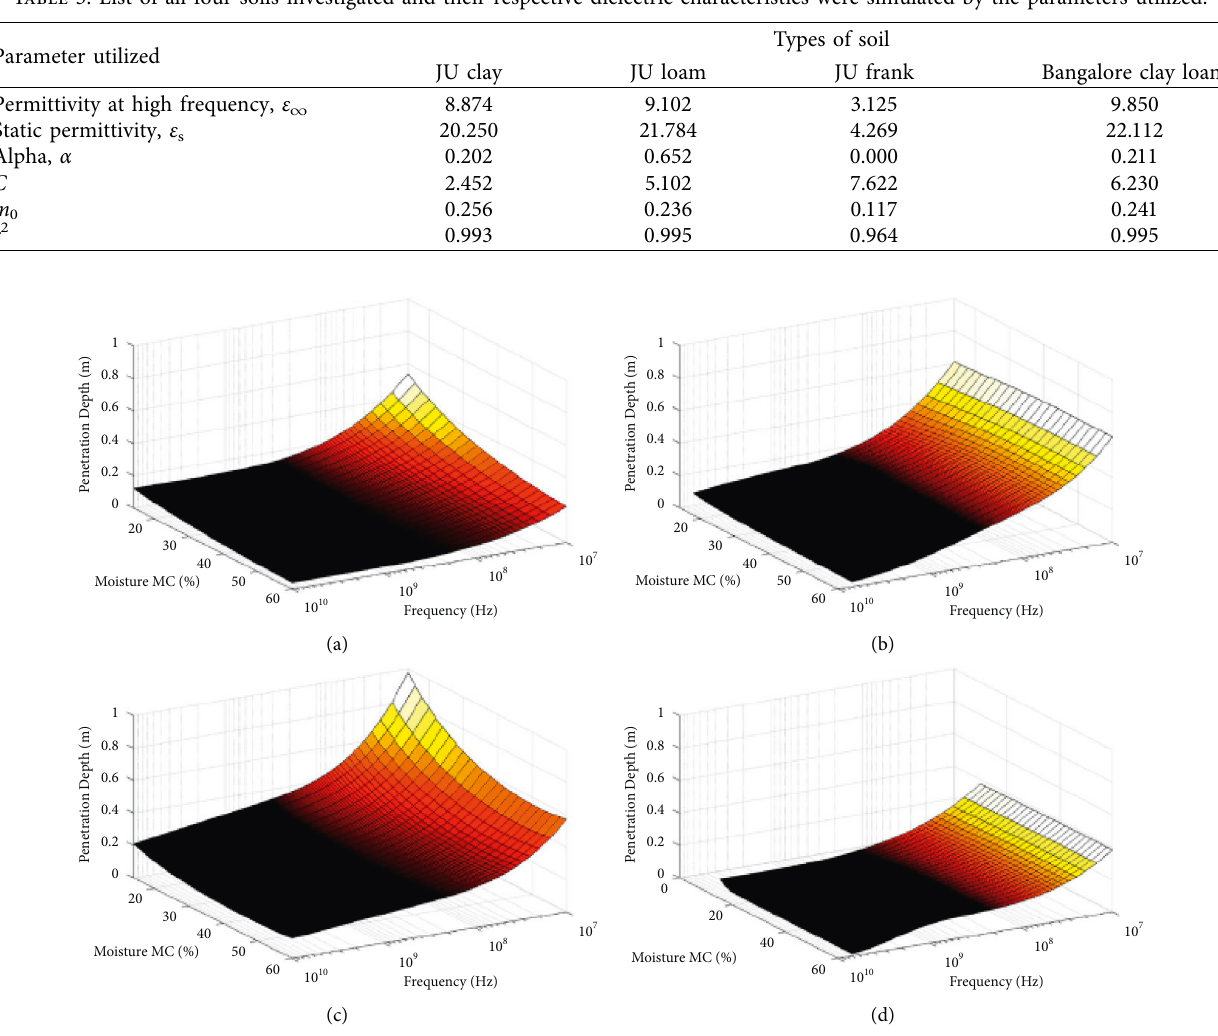
Figure 4: Various depths to which electromagnetic waves can penetrate in contrast to frequency and moisture content for (a) JU clay, (b) JU loam, (c) JU Frank, and (d) Bangalore clay loam soils.